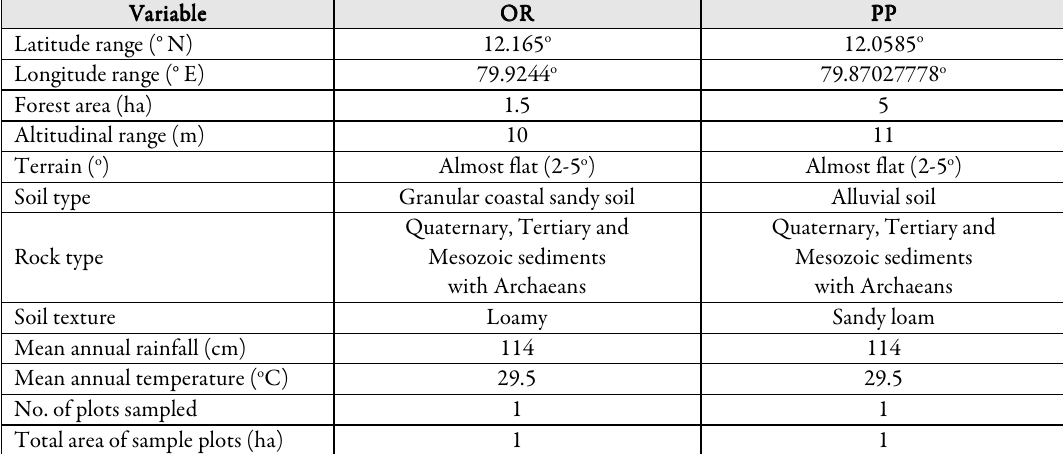
Table 1. Site characteristics and sampled area of Oorani (OR) and Puthupet (PP) tropical dry